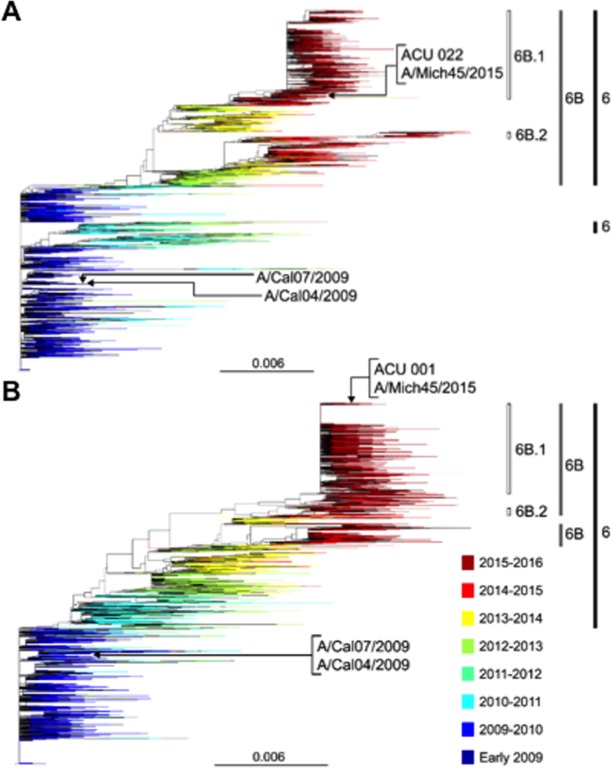
The genetic relatedness of the HA and NA proteins encoded by pH1N1-like viruses circulating since 2009.Phylogenetic reconstruction of HA (A, n = 16,990) and NA (B, n = 15,805) proteins encoded by pH1N1-like viruses. Clades are indicated to the left; branches are colored according to season of isolation.